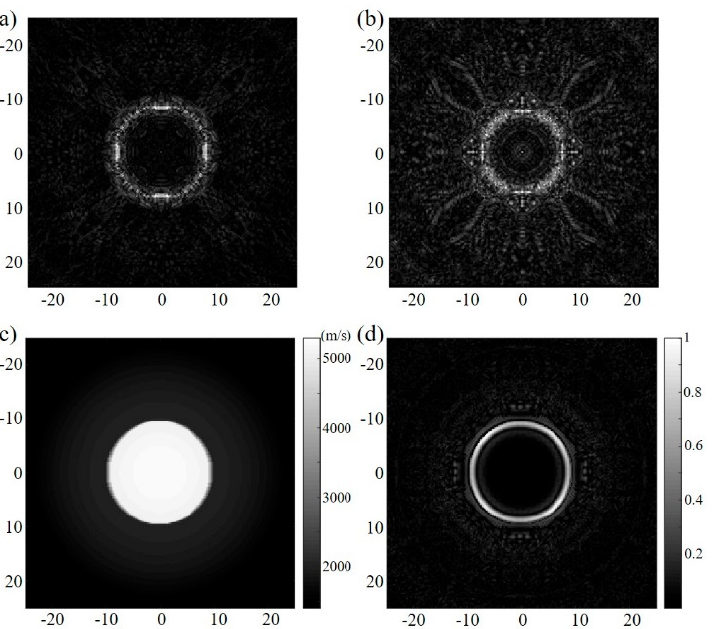
Figure 2. Simulation results. The reflection image from the constant acoustic speed ( a ) 1490 m/s and ( b ) 1540 m/s. ( c ) SoS map derived from the transmission USCT. ( d ) SoS adaptive reflection image in USCT.